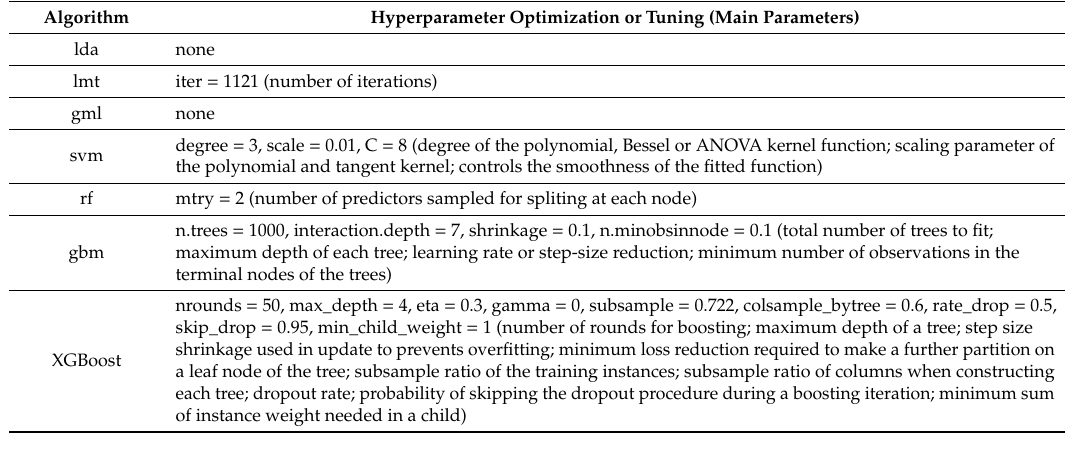
Table 4. Selected algorithms and optimal hyperparameters of the proposed models (tuning). Algorithm